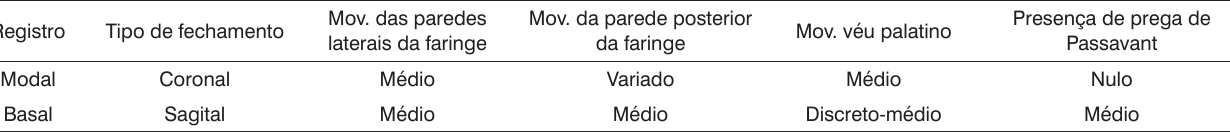
Tabela 2. Preponderância dos resultados da análise das imagens do EVF, conforme tipo de fechamento velofaríngeo e movimentação das estruturas, antes e durante a realização da técnica do som basal, no grupo (resumo dos resultados da Tabela 1)